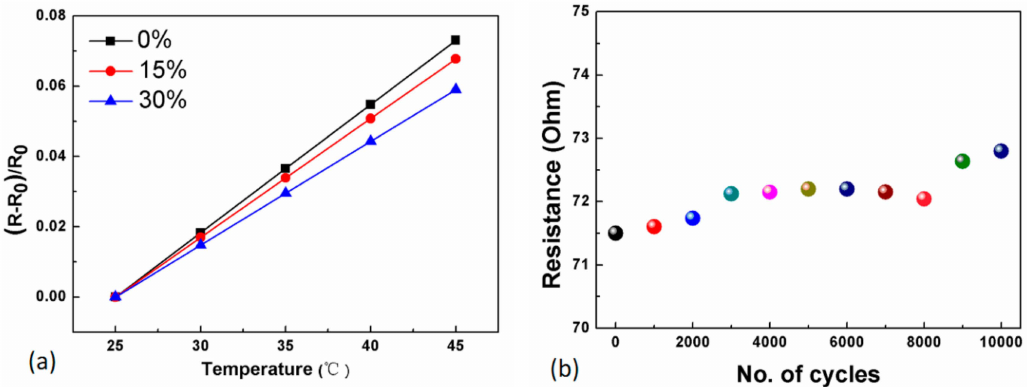
Figure 6. Performance of the whole assembly consisting of fabric temperature sensors connected to FCB. ( a ) Resistance-temperature relation of the fabric temperature sensor connected to the FCB; ( b ) Resistance of the fabric temperature sensor connected to FCB in cyclic stretching processes at 30%